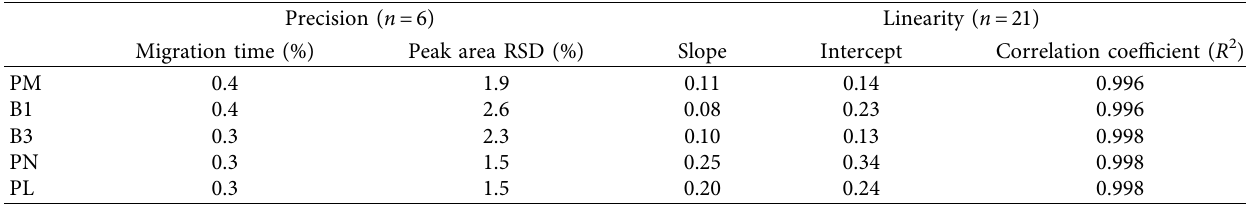
Table 1: Preliminary method validation data: precision on migration time and peak area of six consecutive runs and linearity data over the range 10–110 µ M.